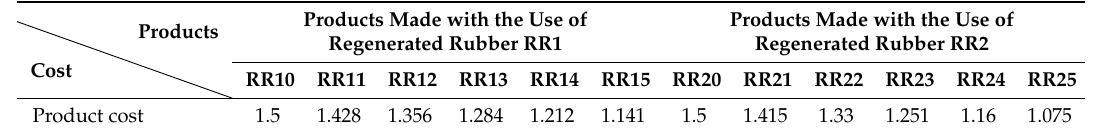
Table 9. The products cost made using RR1 and RR2 regenerated rubber, Eur / kg.